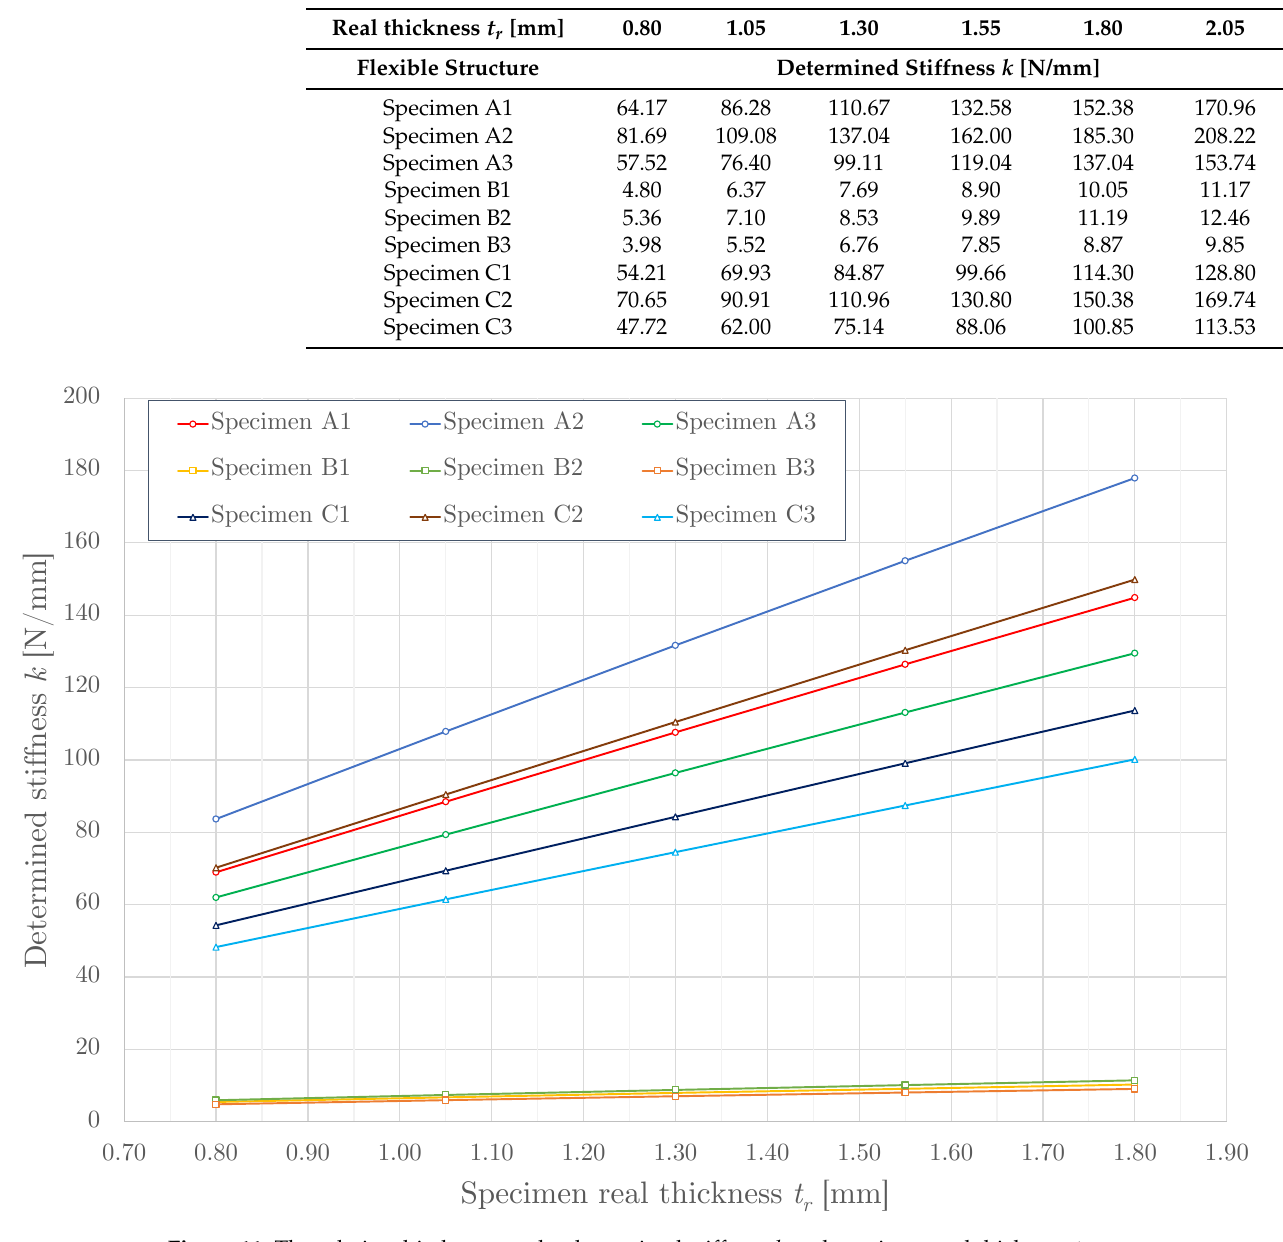
Figure 11. The relationship between the determined stiffness k and specimen real thickness t r . Table 8. Percentage stiffness of A-series